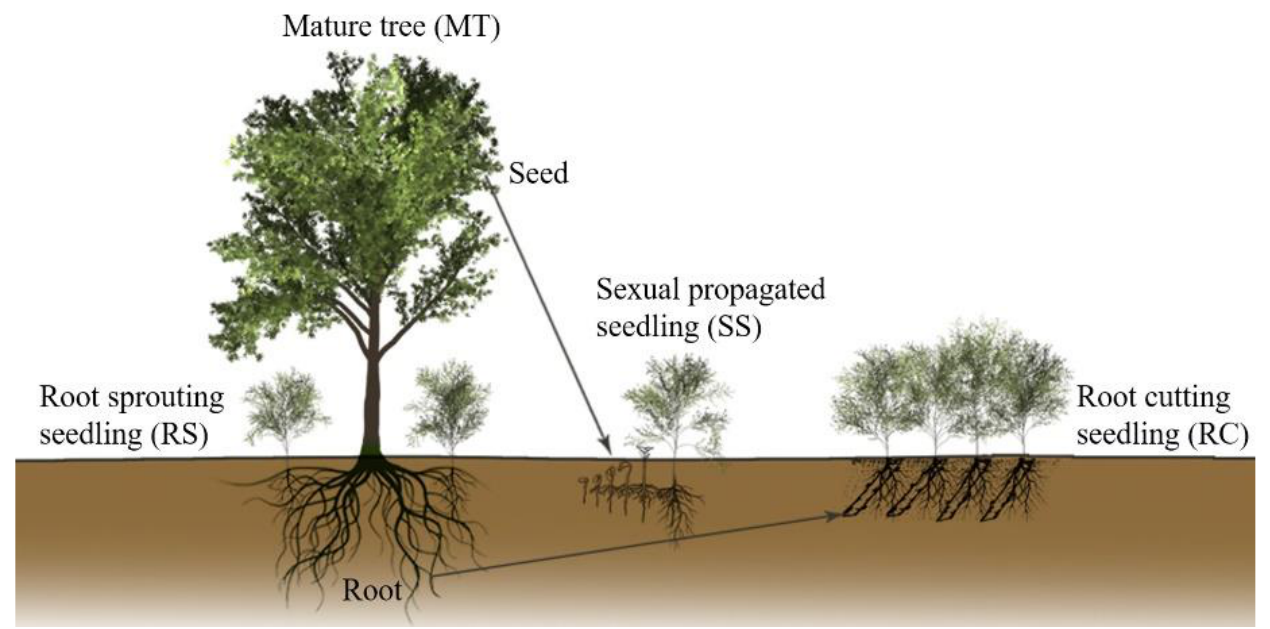
(Figure 1). One-year-old RS, RC, and SS plants, and the MT that produced them were named FRS, FRC, FSS, and FMT, respectively. Two-year-old seedlings and MTs were named SRS, SRC, SSS, and SMT. Leaf samples were collected for transcriptome analysis.